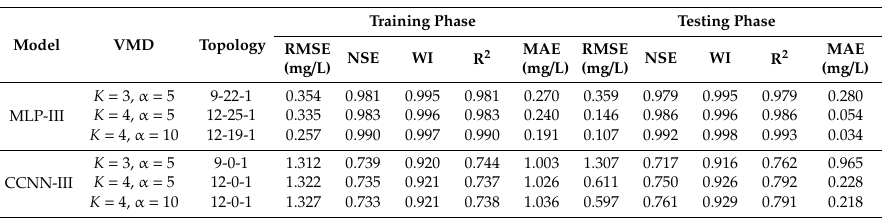
Table 5. Performance statistics using VMD-MLP-III and VMD-CCNN-III models.